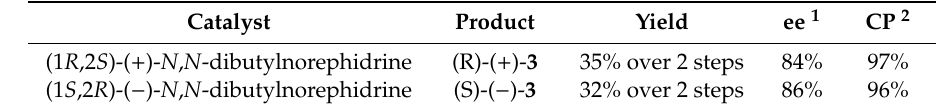
Figure 1. Synthesis of ( + )- and ( − )- δ -heptalactones. Table 1. Yield and purity of δ -heptalactones.